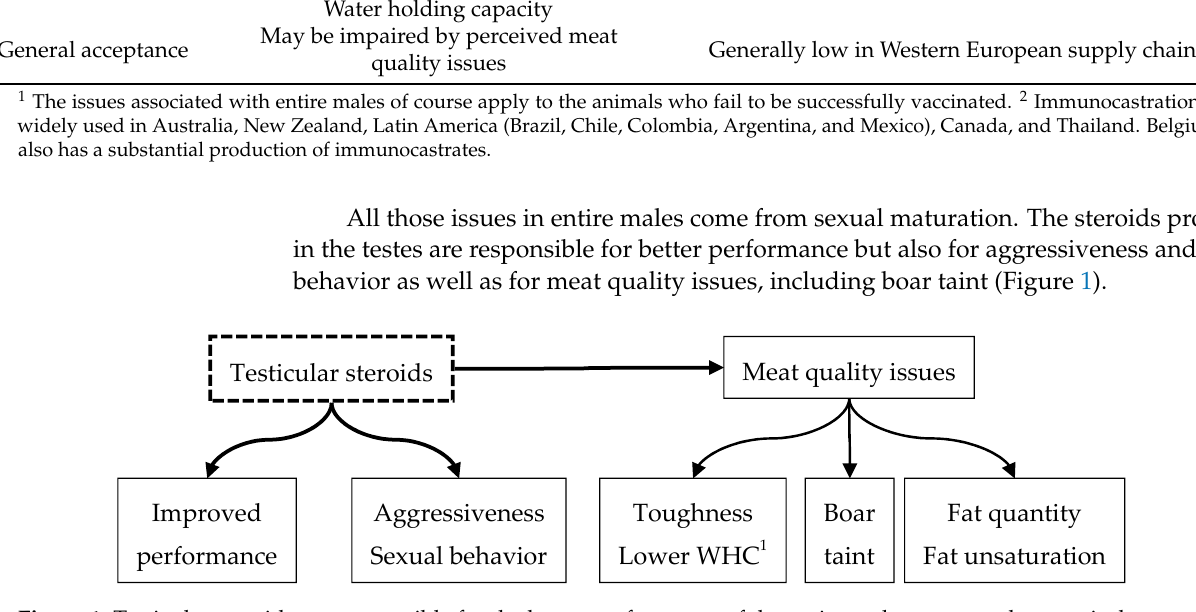
Figure 1. Testicular steroids are responsible for the better performance of the entire males compared to surgical castrates, but also for male-specific behaviors and lower meat quality ( 1 WHC:water holding capacity = the extent to which meat can keep its juice when maturing “drip loss” or cooking “cooking loss”).